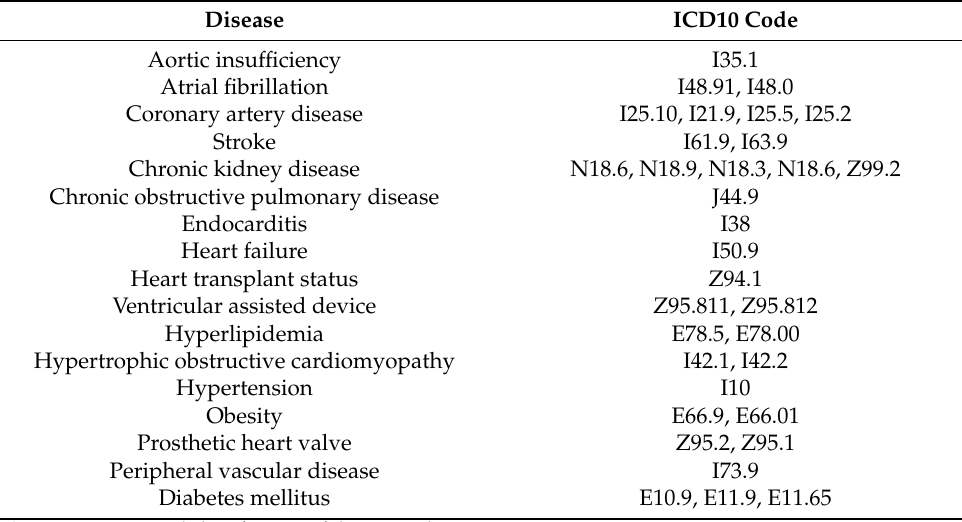
Table A1. ICD-10 codes used to define